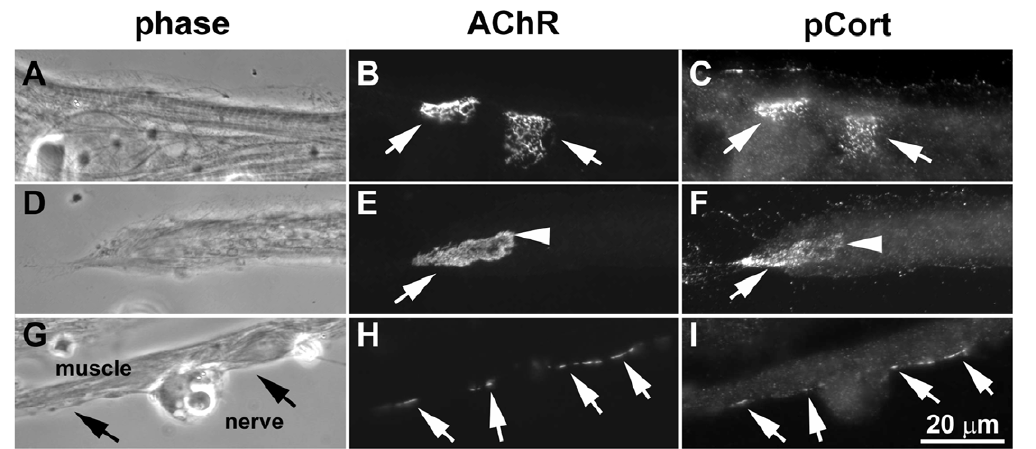
Figure 3. Cortactin phosphorylation at AChR clusters induced by growth factor-coated beads and agrin. R-BTX-labeled Xenopus muscle cells were stimulated overnight with HB-GAM-beads (A-C) or neural agrin (D-F). In cells exposed to beads (A; asterisks) AChRs aggregated at bead-muscle contacts (B; arrows) and strong labeling was detected at these bead-induced AChR clusters for Y482-phospho-cortactin (C; arrows). Treatment of muscle cells with agrin (D) generated numerous small ( , 0.5-3 m m) AChR clusters (D; arrows) and antibody labeling showed that phospho-cortactin was enriched at these clusters (E; arrows) and also along myopodia that formed near the AChR clusters (F; arrows and arrowheads).